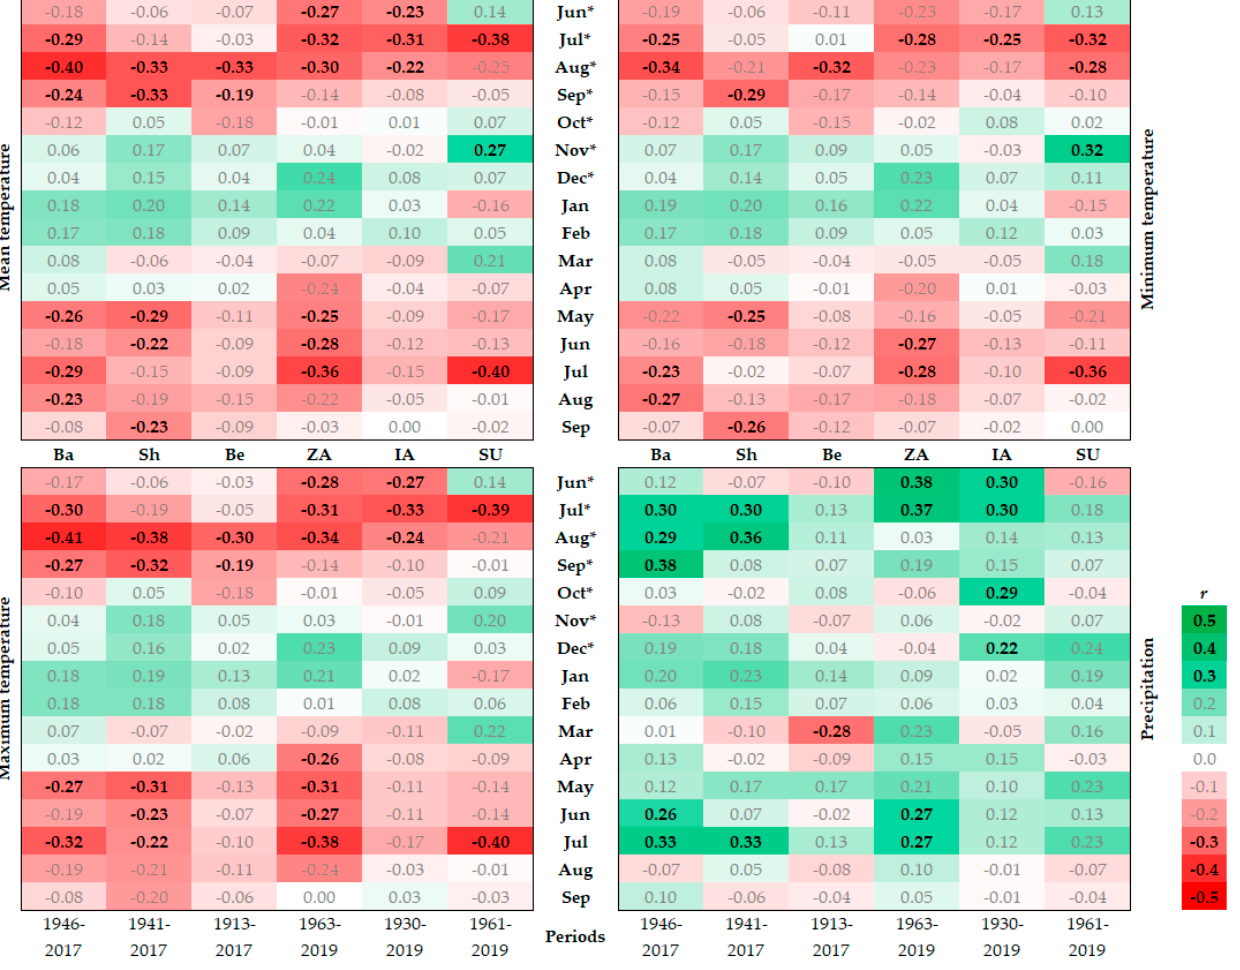
Be—Beskaragay, ZA—Zhongar-Alatau, IA—Ile-Alatau, and SU—Sairam-Ugam) with monthly series